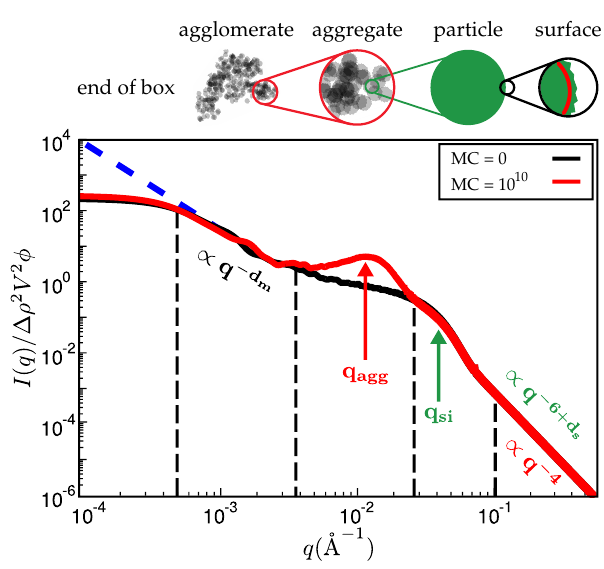
Figure 7. Reduced scattered intensity vs. magnitude of the scattering vector, q . The figure depicts the different q -regimes. The limit of large q is governed by Porod’s law or, in the case of fractal particle surfaces, by the attendant law exhibiting a fractal dimension. Subsequent q -regimes contain information on the size of the particles, their aggregates and the filler network itself. Due to the finite size of the simulation cell, there is a plateau terminating useful information at small q . The observed structure of course depends on the number of MC steps. System ingredients used here are the same as in Figure 4. The filler volume content is φ = 20% and temperature is T = 160 ◦